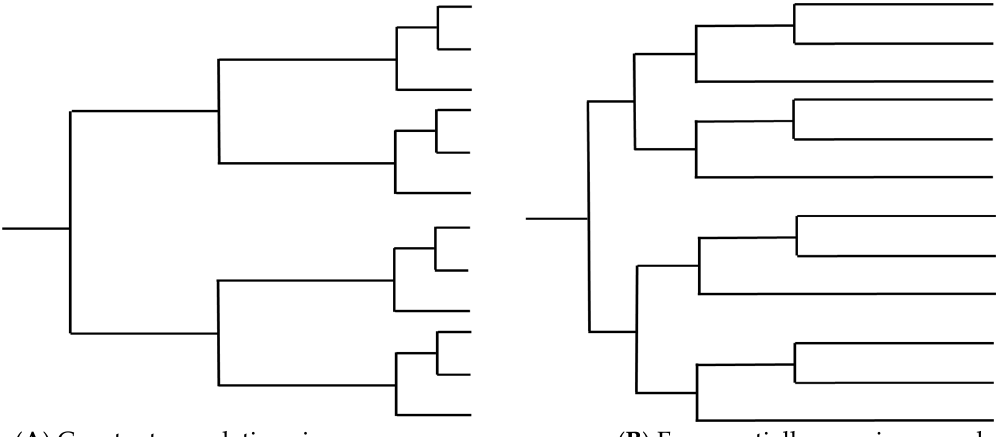
Figure 3. Examples of tree topology from ( A ) a population with constant population size and ( B ) a population undergoing exponential growth. High levels of recombination in a set of isolates can lengthen terminal branches, leading to trees that resemble ( B ) and resulting in incorrect inference relating to population dynamics over time.